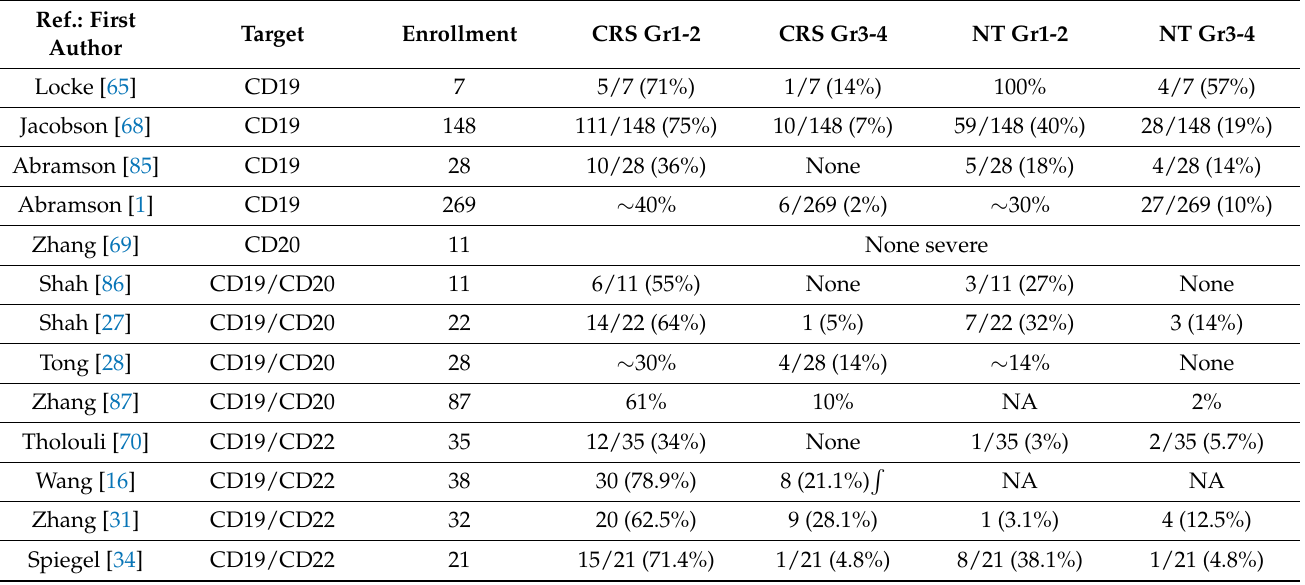
Table 7. Comparison of CRS and NT in dual-targeting CAR T-cell therapy with Si-CAR-T therapy in